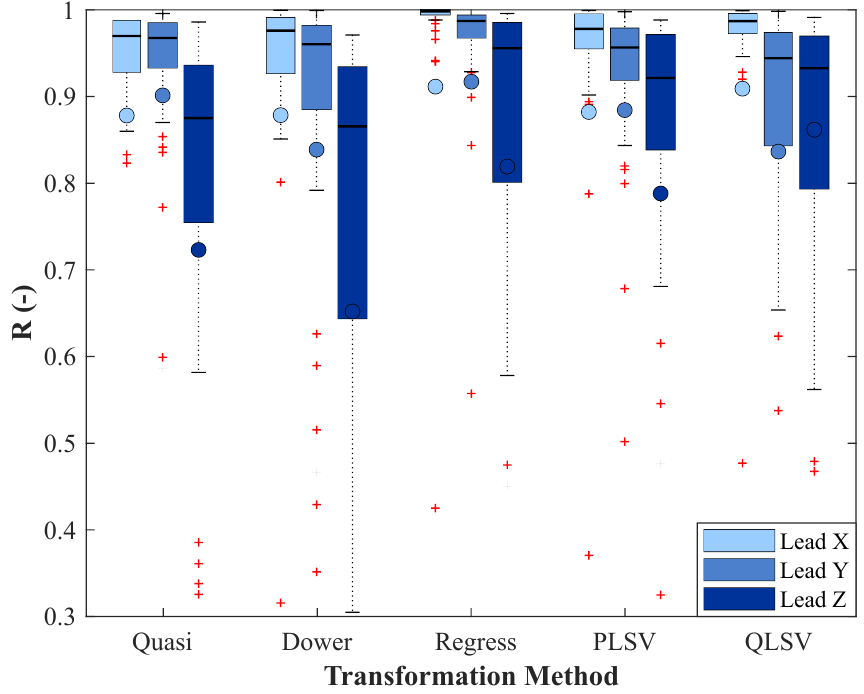
Figure 6. Box plot for comparison of the methods based on the correlation coefficient.